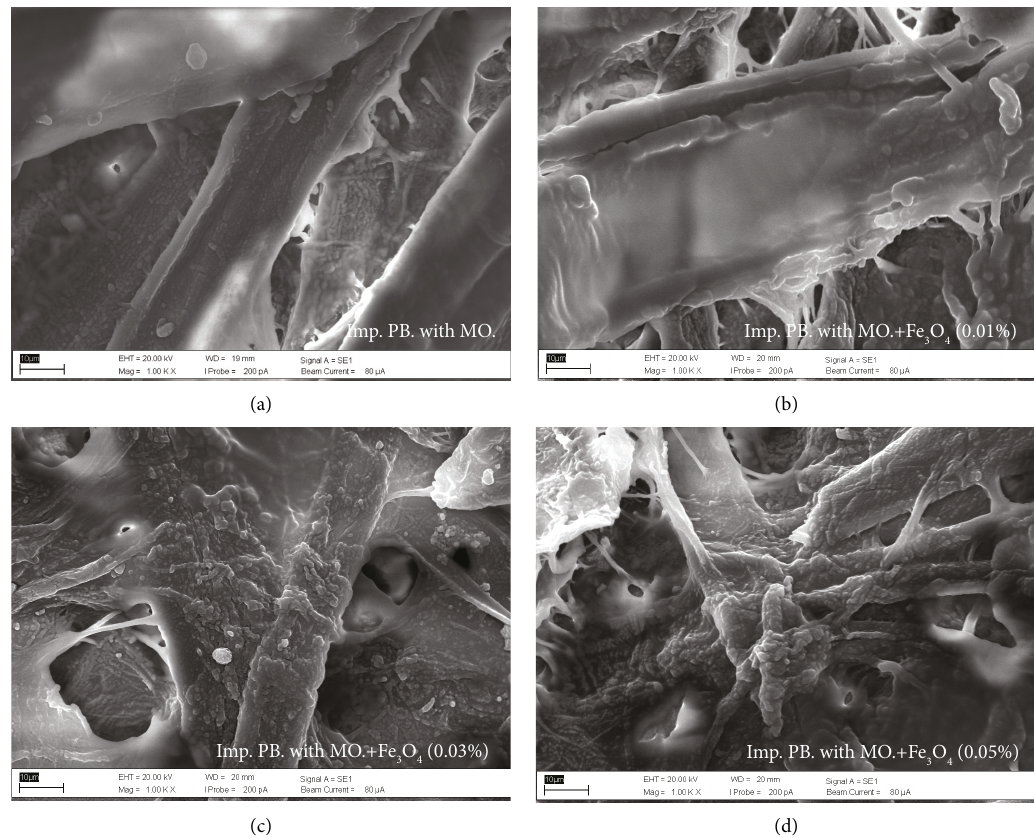
Figure 7: Scanning electron microscopy (SEM) images of the pressboard surface. (a) The surface features of impregnated pressboard with conventional mineral oil. (b) The surface features of impregnated pressboard with mineral oil-based Fe 3 O 4 (0.01%). (c) The surface features of impregnated pressboard with mineral oil-based Fe 3 O 4 (0.03%). (d) The surface features of impregnated pressboard with mineral oil-based Fe 3 O 4